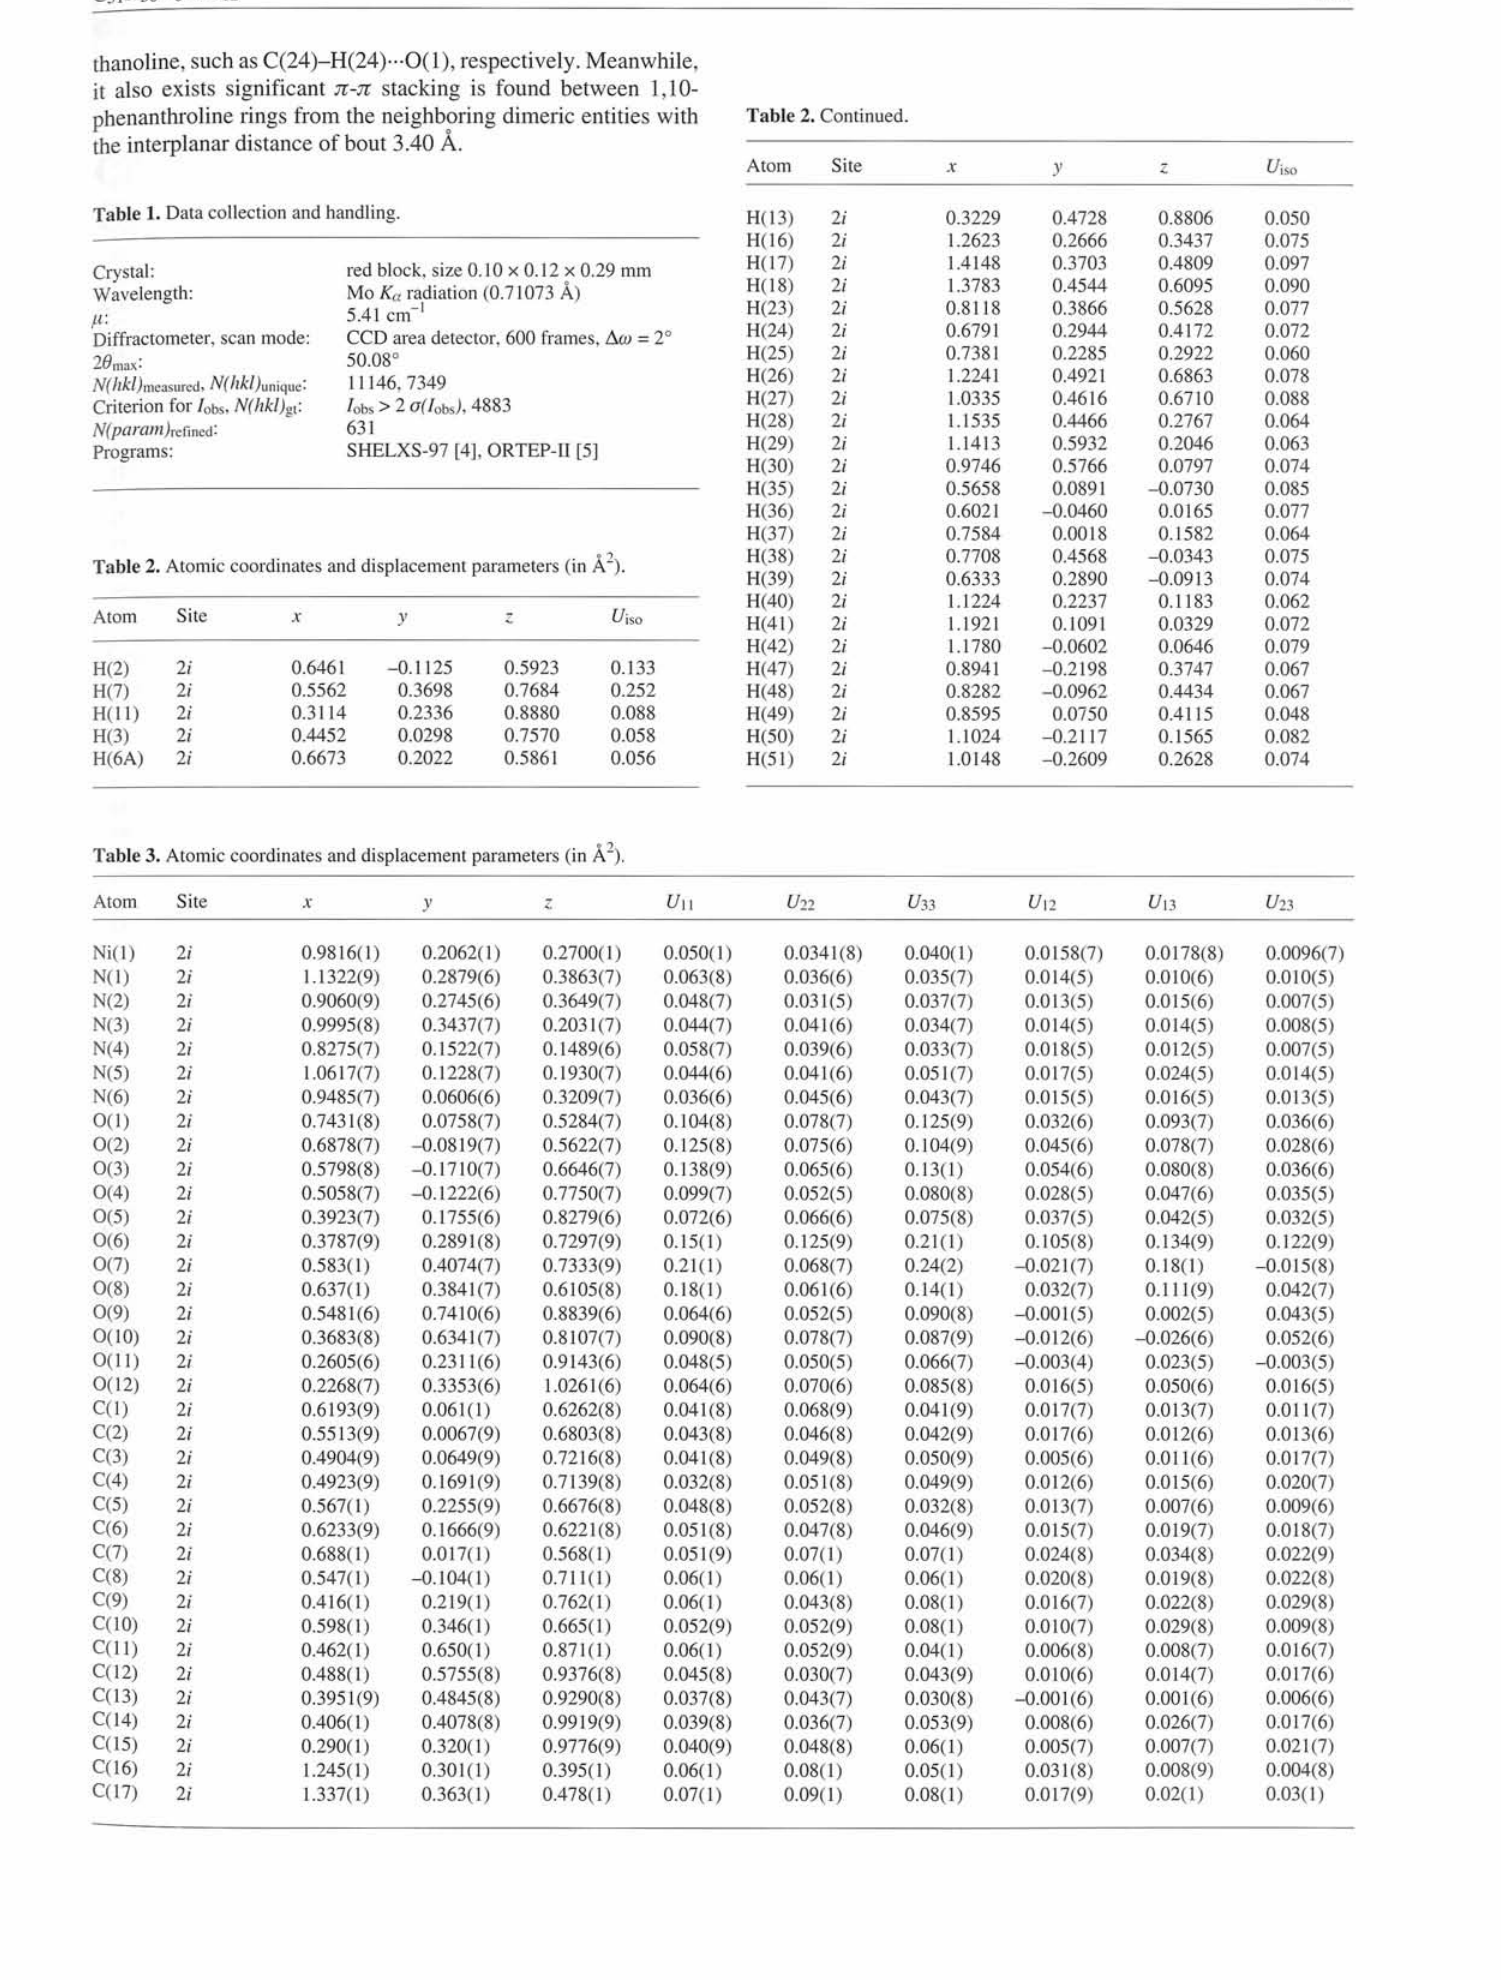
Table 1. Data collection and handling.